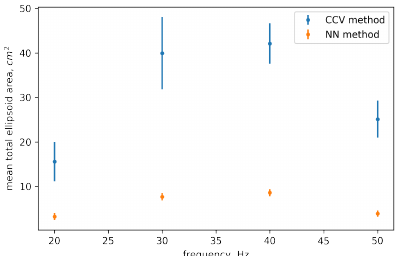
Figure 34. The arithmetic ellipsoidal surface area of bubbles was obtained from the elliptical approxi- mation of the third axis by the CCV method (blue) and for cluster surface area for NN (orange). One can see that the ratio is similar to the one with the 2D area estimate. It requires more tests; however, the first conclusion is a 2D area estimation instead of a 3D one since we need to calibrate results anyway and for the calibration procedure absolute values are not that crucial, while the ratio